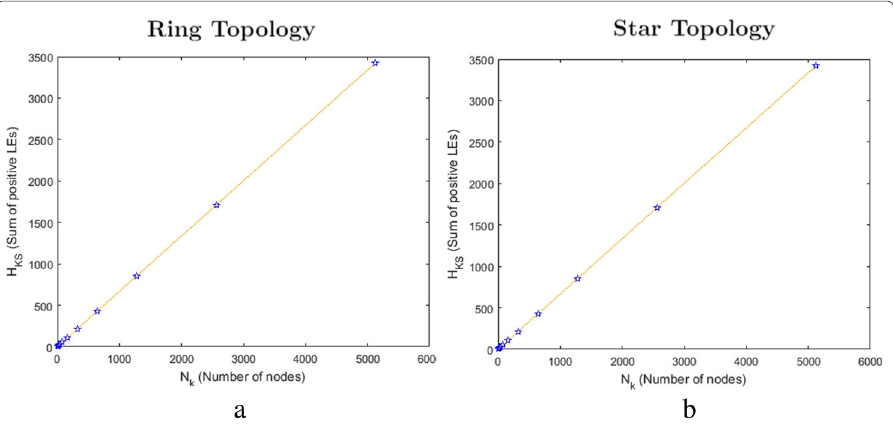
Fig. 2 The sum of positive LEs with respect to the number of nodes for networks satisfying case 1 with ( a ) ring and ( b ) star topology. For each network we considered the building block with N 0 = 5 and ε = 2 · 10 − 4 . The inter-coupling of the network (cid:2) ( 1 ) is γ( 1 ) = 0.05 and k = [1,2, ... ,10]. The fitting in ( a ) produces p 1 = 0.6676 and p 2 = − 0.0057 and the one in ( b ) produces p 1 = 0.6677 and p 2 = − 0.0057, where p 1 is the slope and p 2 is the constant coefficient of the